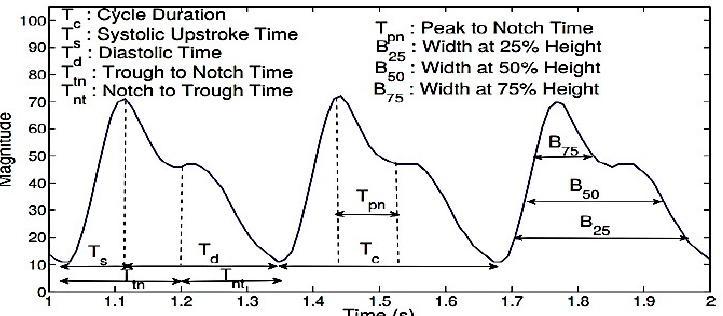
Figure 3. The PPG features commonly used in prior studies related to BP are the cycle duration (Tc), systolic time (Ts), diastolic time (Td), trough to notch time (Ttn), notch to trough time (Tnt), peak to notch time (Tpn), and the sum of the systolic and diastolic widths at 25% (B25), 33% (B33), 50% (B50), and 75% (B75) of the signal amplitude in each cycle.